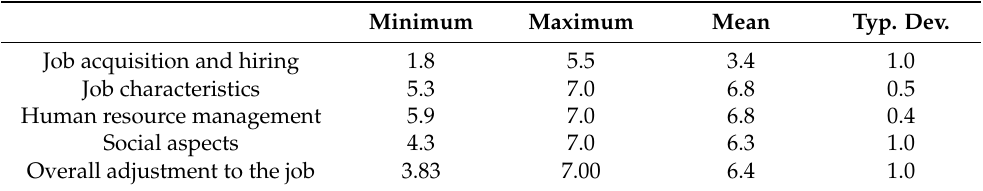
Table 8. Statistics descriptive of the factors of the Typicalness Questionnaire.